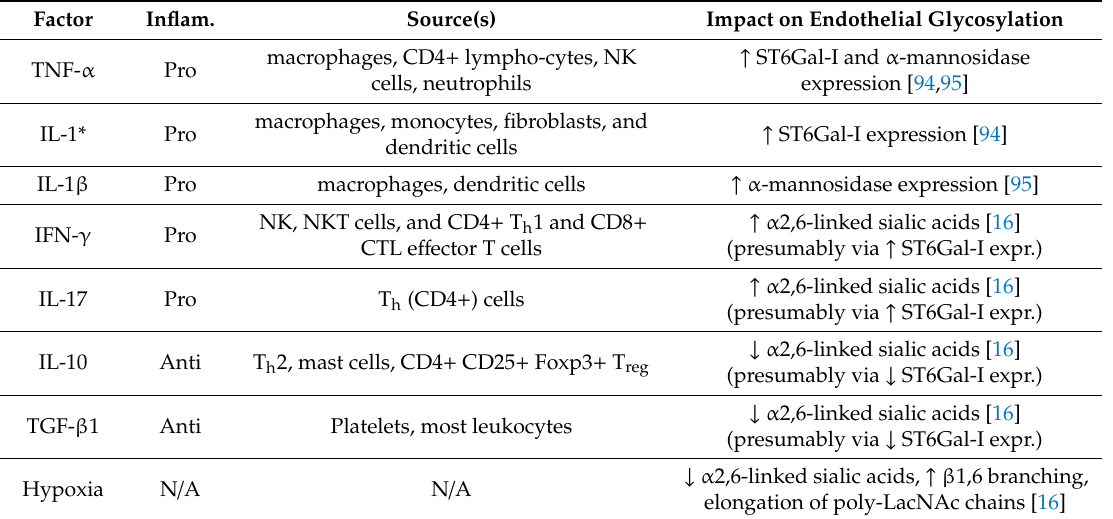
Table 1. Factors that influence endothelial cell glycosylation. Pro- and anti-inflammatory actors that have been reported to impact endothelial cell glycosylation are